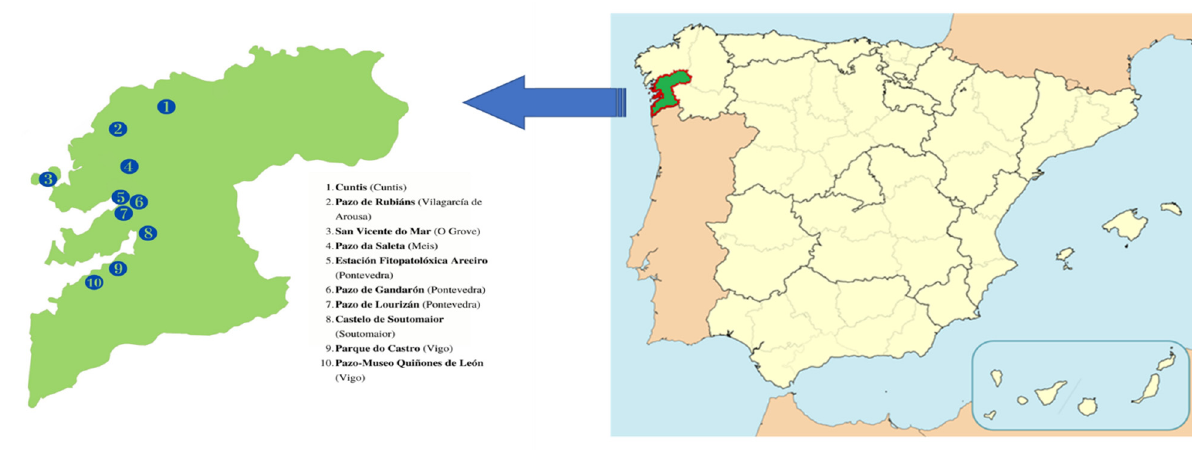
Figure 1. Camellia Figure 1. Camellia locations. Table 1. Origin and quality parameters of Camellia seed oils.